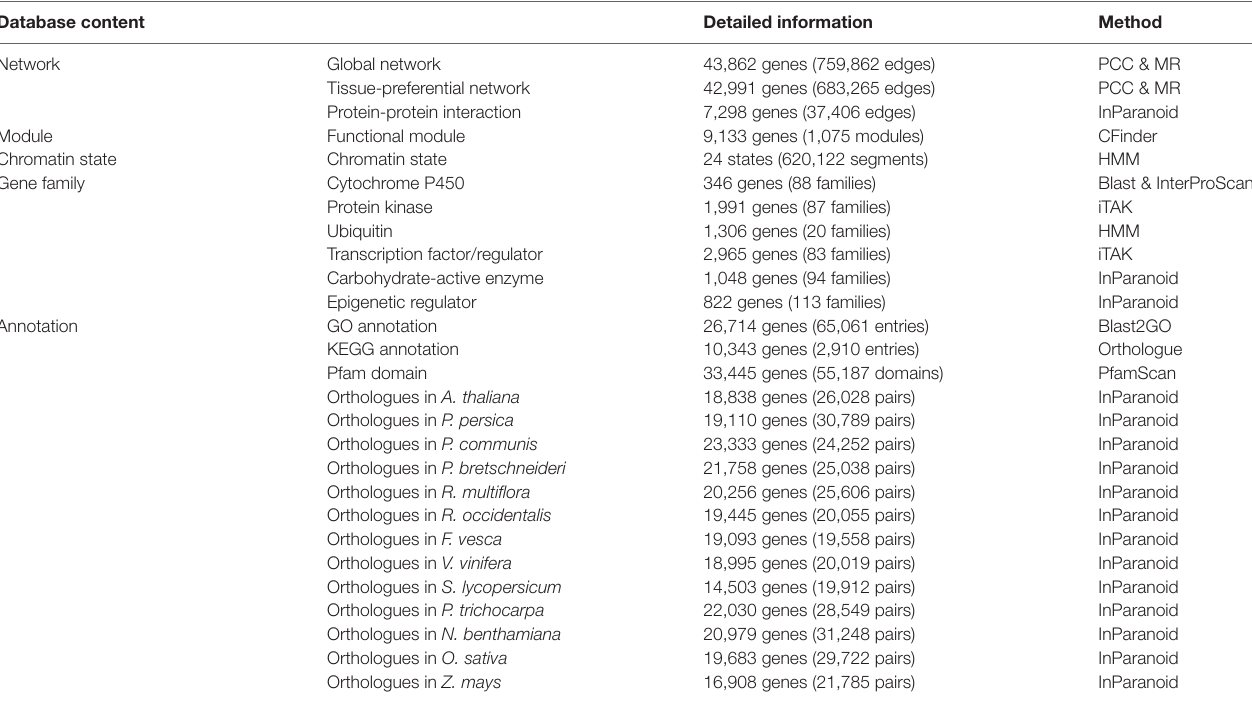
TABLE 3 | AppleMDO